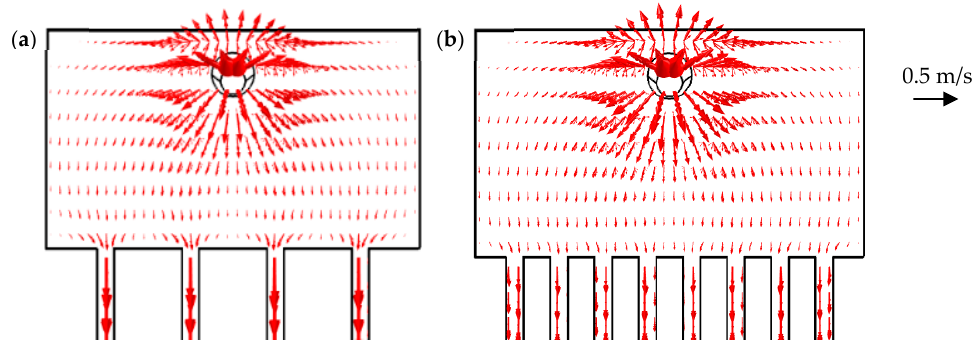
Figure 20. FDU study for different numbers of channels for a 100 mL/min fluid flow at a scale of 5. ( a ) Velocity profile for four-channel configuration. ( b ) Velocity profile for eight-channel configuration.